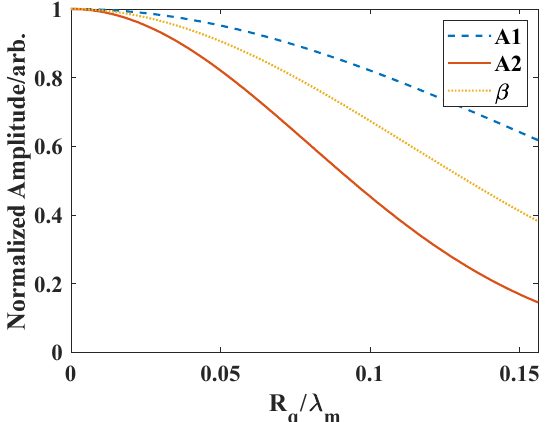
Figure 3. The change curves of normalized fundamental amplitude, second harmonic amplitude, and nonlinear parameter in the through-transmission mode with surface roughness R q .